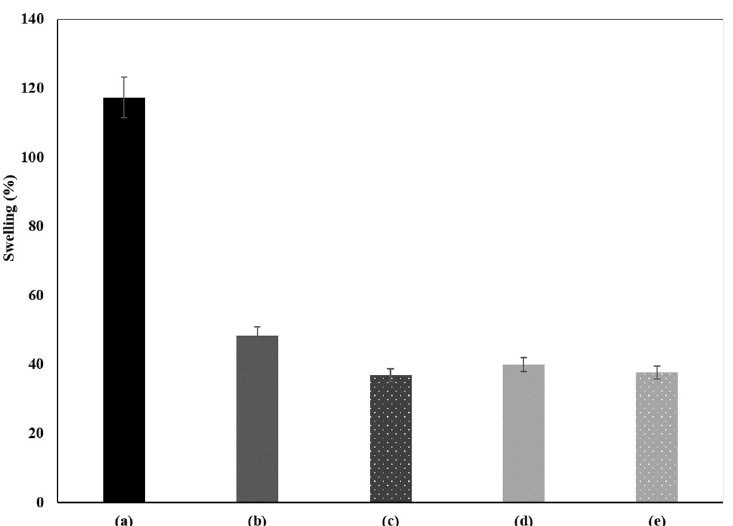
Fig 7. Swelling capacity analysis of polyaniline polymerized by laccase: (a) bleached BC; (b) aniline + without laccase + HBT (WB); (c) aniline + laccase + HBT (WB); (d) aniline + without laccase + HBT (US); (e) aniline + laccase + HBT